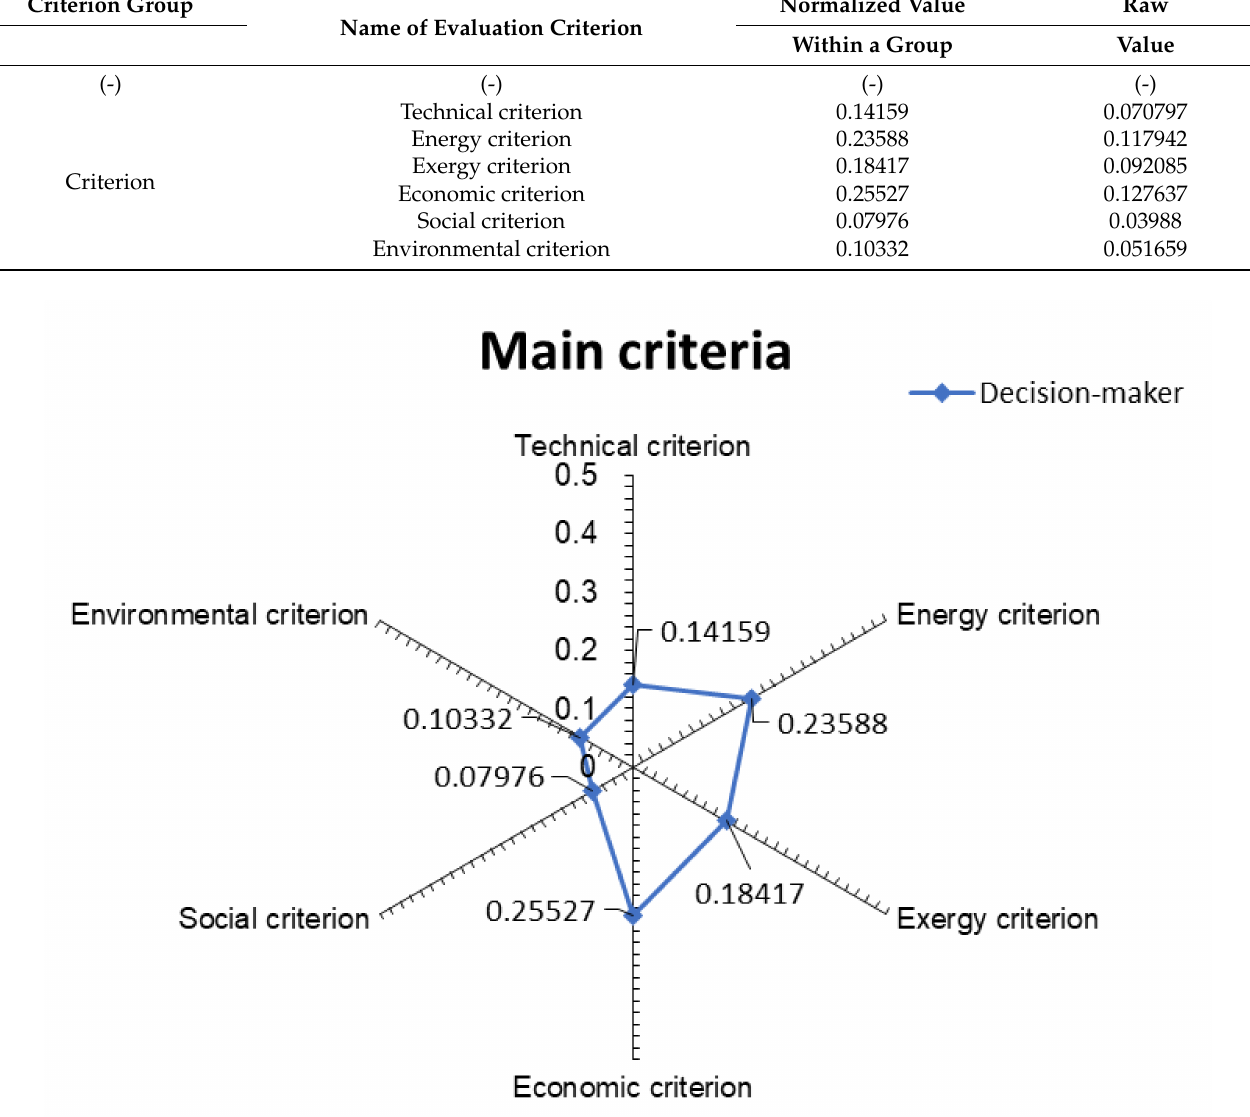
Figure 2. Comparison of the evaluations of all decisionmakers’